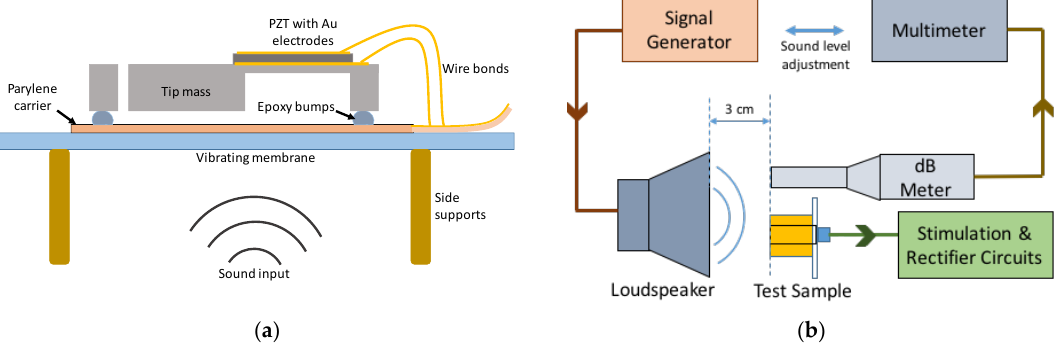
Figure 1. ( a ) Schematic view of the piezoelectric transducer on the ear drum mimicking membrane. Parylene carrier is attached onto the membrane with a double-sided tape; ( b ) Schematic view of the acoustic test